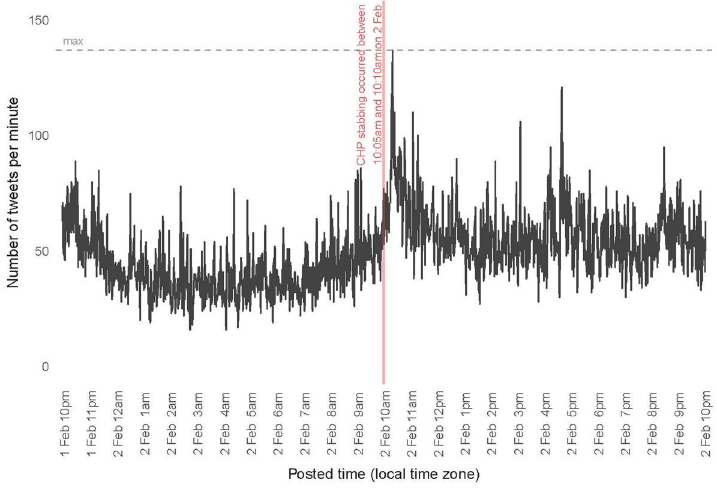
Fig 3. Tweets per minute during a high profile, low victim event during Super Bowl